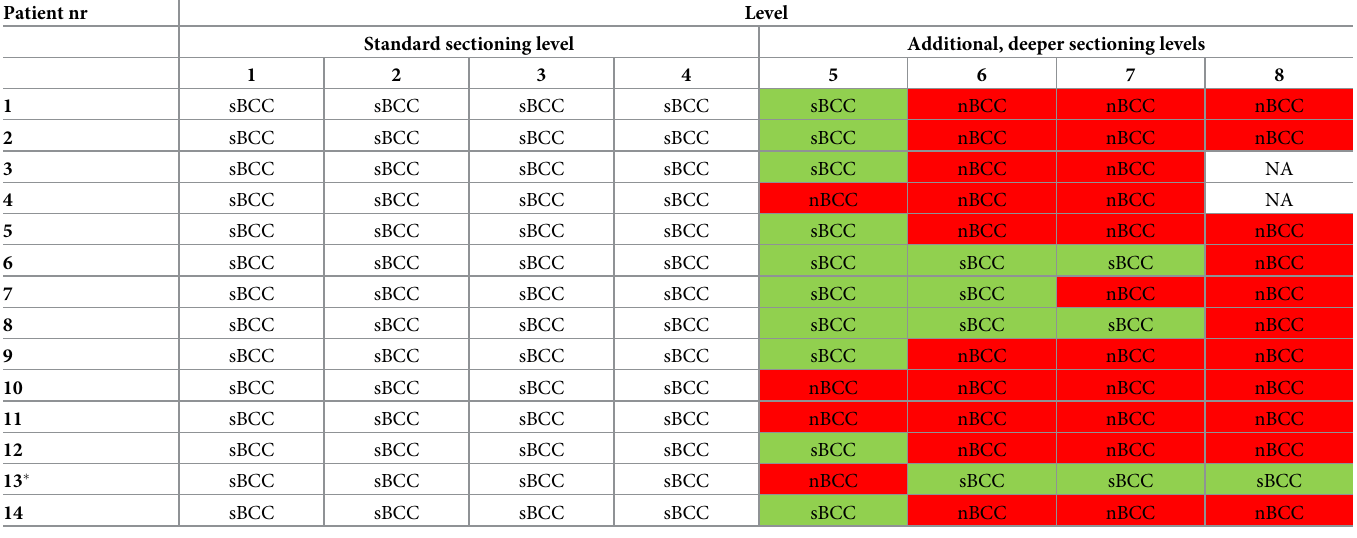
Table 3. Overview of HE levels of the 14 patients with a more aggressive BCC component in deeper HE slides (levels 5–8). All patients had a deeper, nodular compo- nent. sBCC = superficial basal cell carcinoma, nBCC = nodular basal cell